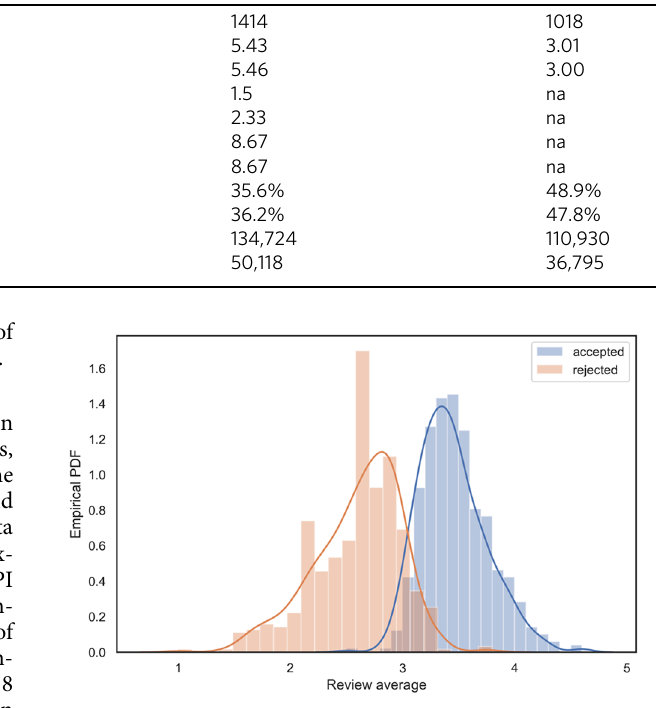
Fig. 3 WCNC distribution of average review score for accepted and rejected papers. Empirical probability distribution function of the average review score for accepted (in blue) and rejected (in orange) WCNC papers.